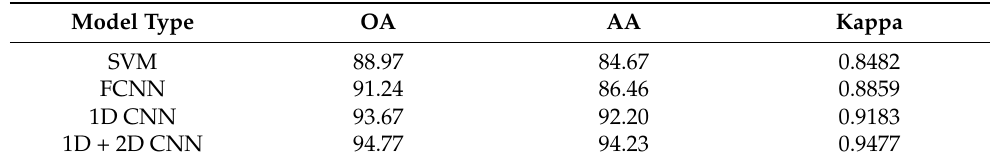
Table 4. Test accuracy of the DNN models and SVM.